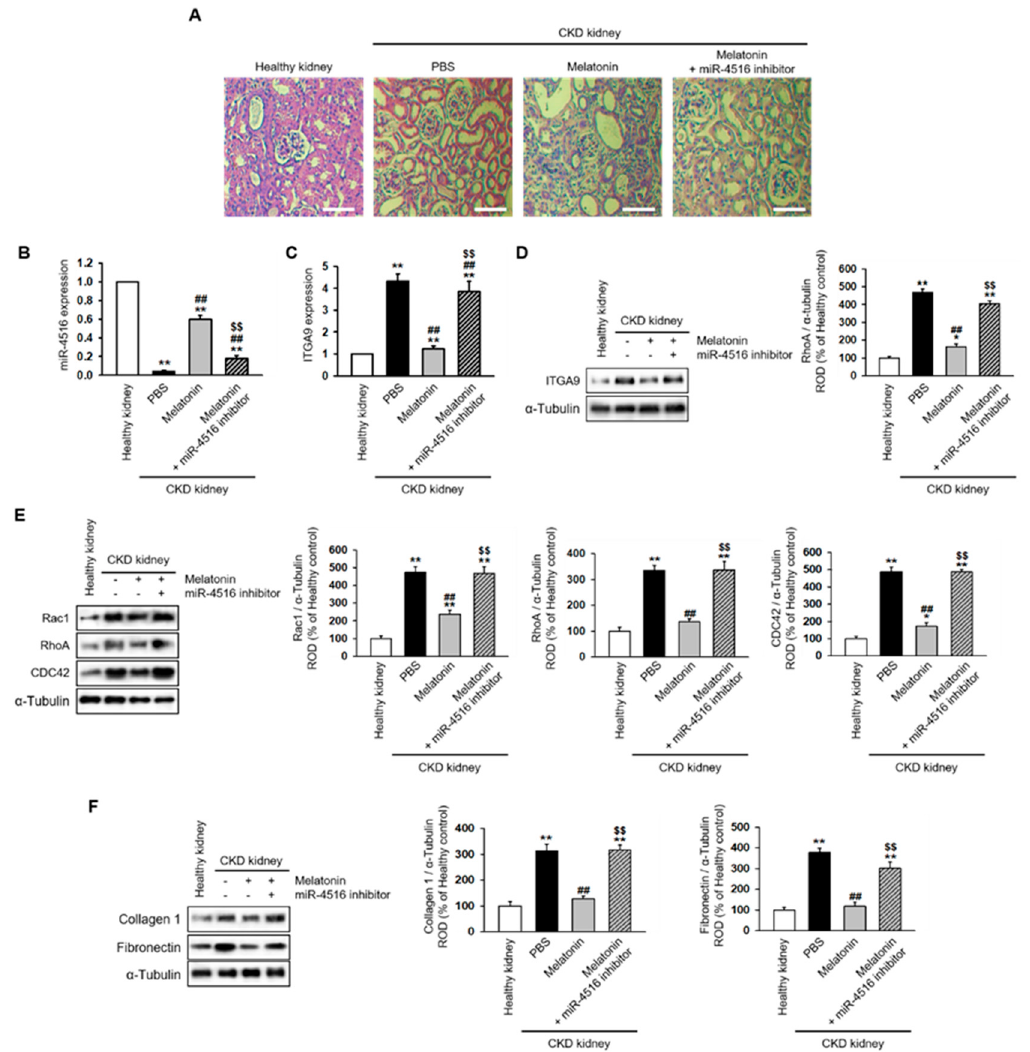
Figure 6. Melatonin injection restores renal cortical fibrosis in a CKD mouse model via increased expression of miR-4516. ( A ) Hematoxylin and eosin (H&E) staining was performed on kidney sections from a CKD mouse model following melatonin injection, or melatonin inhibition with miR-4516 inhibitor (scale bar = 1000 μ m). ( B , C ) Expression of miR-4516 and ITGA9 was detected in the kidney cortex in each group by qPCR ( n = 3). ( D – F ) Western blot analysis for ITGA9, Rac1, RhoA, CDC42, collagen type 1, and fibronectin expression using samples from the kidney cortex of each mouse model group ( n = 3). Protein levels were determined by densitometry relative to α -tubulin. The values represent mean ± SEM. * p < 0.05, ** p < 0.01 vs. healthy kidney, ## p < 0.01 vs. phosphate buffered saline (PBS), $$ p < 0.01 vs. melatonin.